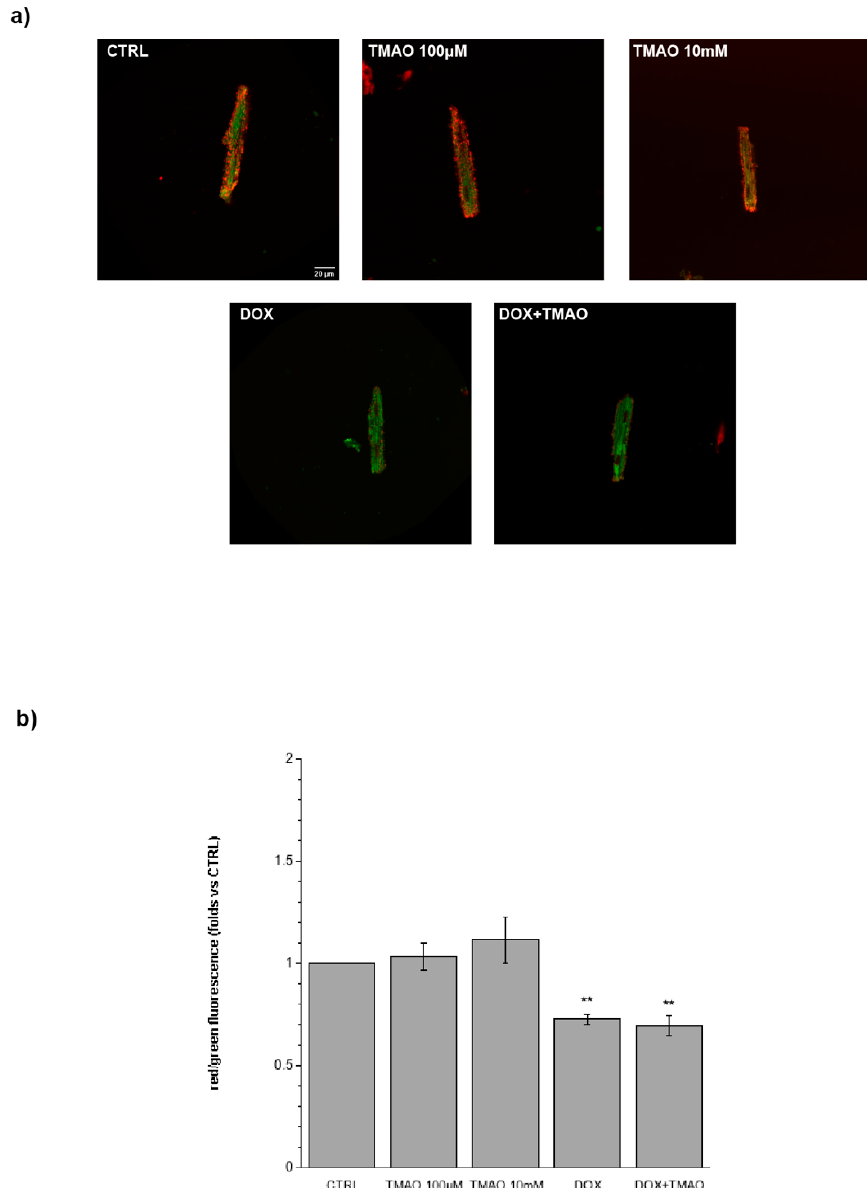
Figure 6. Mitochondrial membrane potential variation following 24 h treatment. ( a ) Confocal microscopy images of cells treated with TMAO 100 µ M and TMAO 10 mM for 24 h and labeled with the JC-1 probe. In these experiments, doxorubicin (DOX) is used as a positive control (60 × magnification). ( b ) Bar graph showing red / green fluorescence after 24 h of treatment, no variations of mitochondrial membrane potential are detected, a little but significant reduction of the ratio is visible after DOX treatment used here as a positive control, condition not changed in a simultaneous treatment with TMAO (refer to the main text for numerical values).